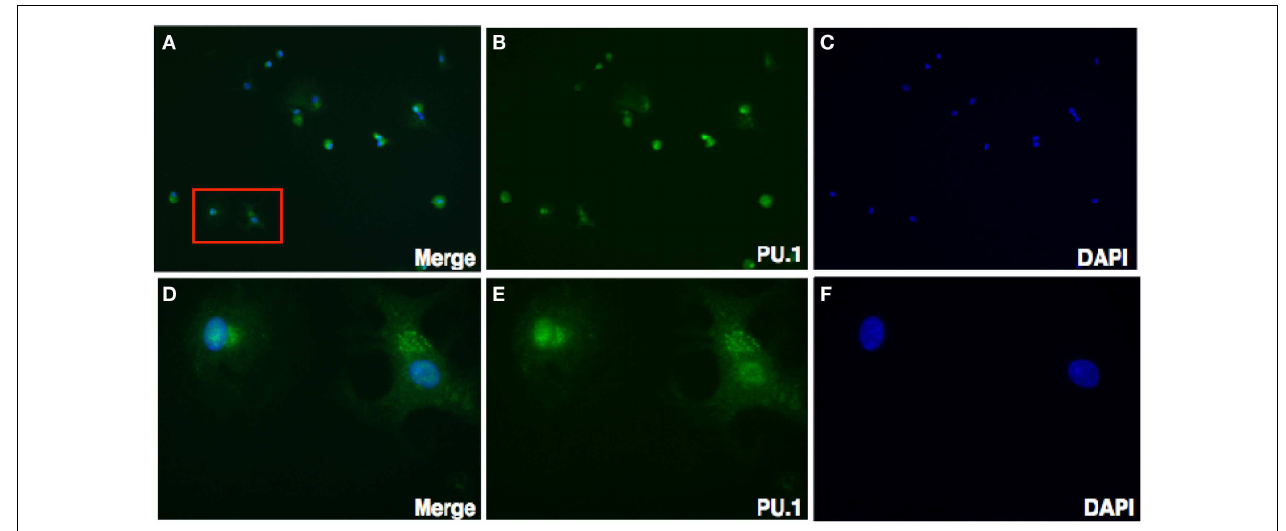
out using Axiolmager Z1 fluorescent microscope. Decidual cells stained with DAPI, PU.1 and overlay at 40 × magnifications (A–C) . Cells in red box (A) indicate the same at higher magnification, 100 × oil immersion stained with DAPI, PU.1, and overlay in (D–F)